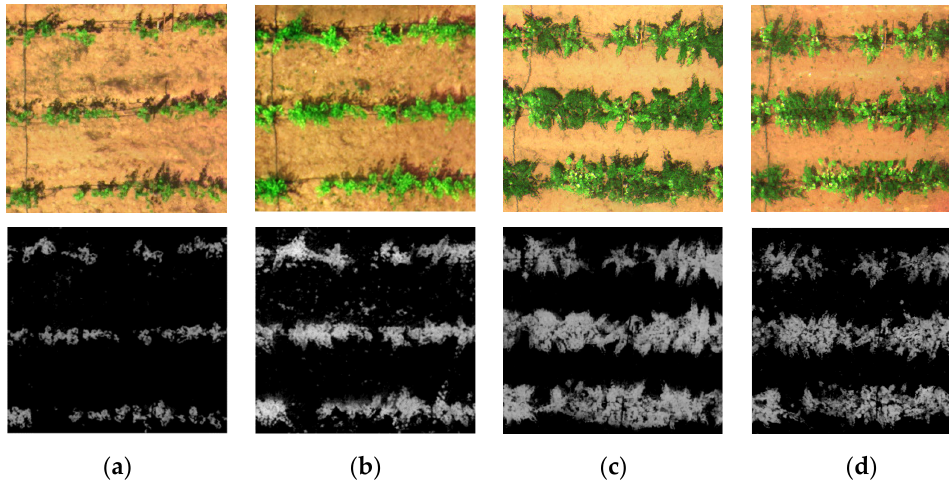
Figure 2. ( a ) Effects of eliminating soil background at new shoot growth stage (8 May 2021); ( b ) effects of eliminating soil background at flowering stage (31 May 2021); ( c ) effects of eliminating soil background at fruit expansion stage (22 June 2021); ( d ) effects of eliminating soil background at